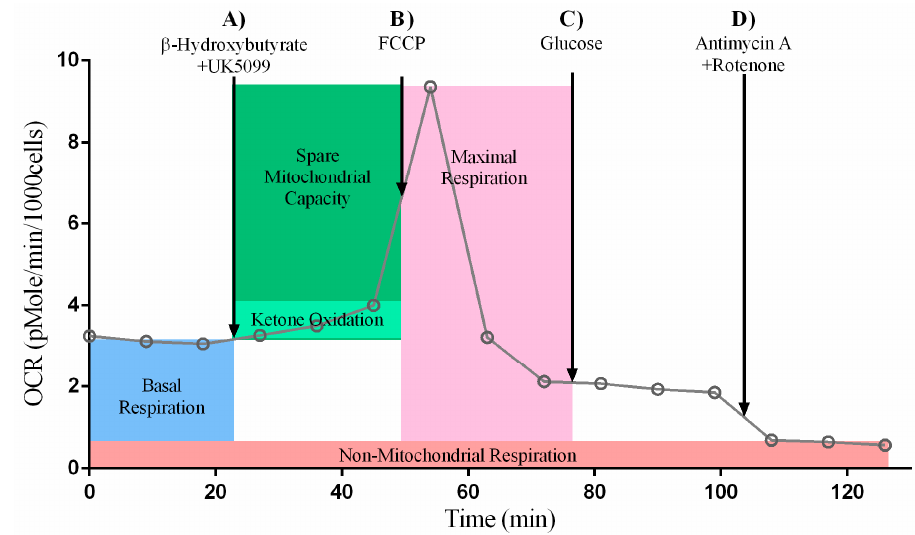
Figure 10. Schematic representation of the ketone stress test (KST) for assessing mitochondrial respiration in terms of oxygen consumption rate (OCR).